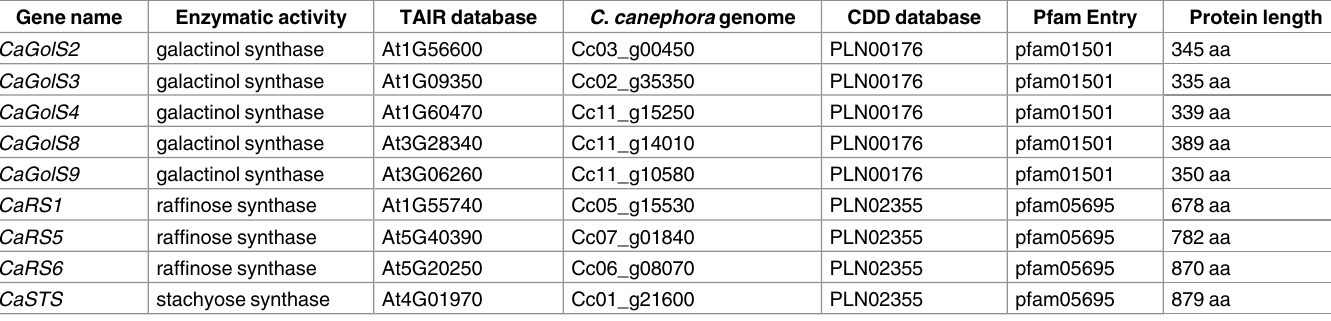
Table 5. Raffinose family oligosaccharide candidate